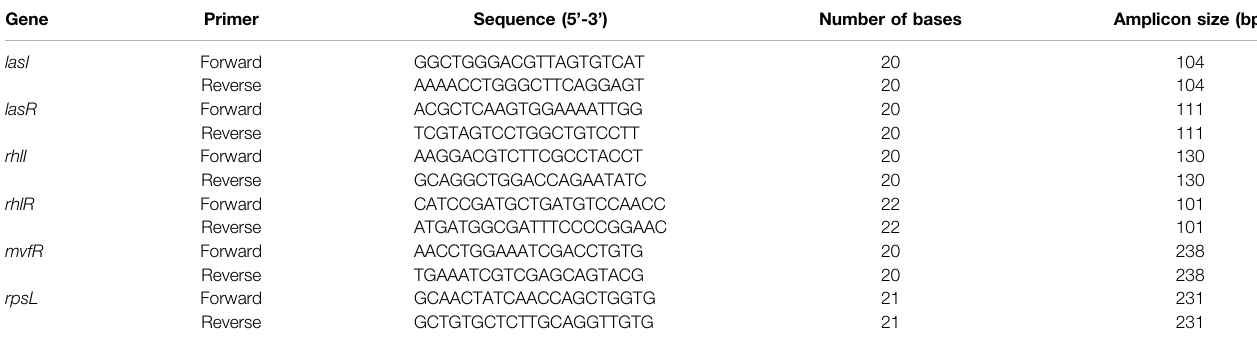
TABLE 1 | List of primers used in qRT-PCR